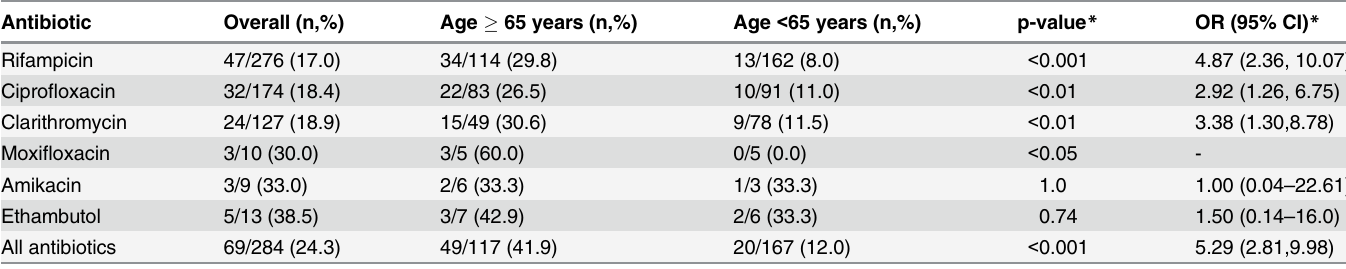
(29.5%) had surgery alone and 148 (70.5%) had surgery plus antibiotics. There was no differ- ence in the proportions who had surgery alone between the age-groups (p = 0.96). Table 2. Antibiotic